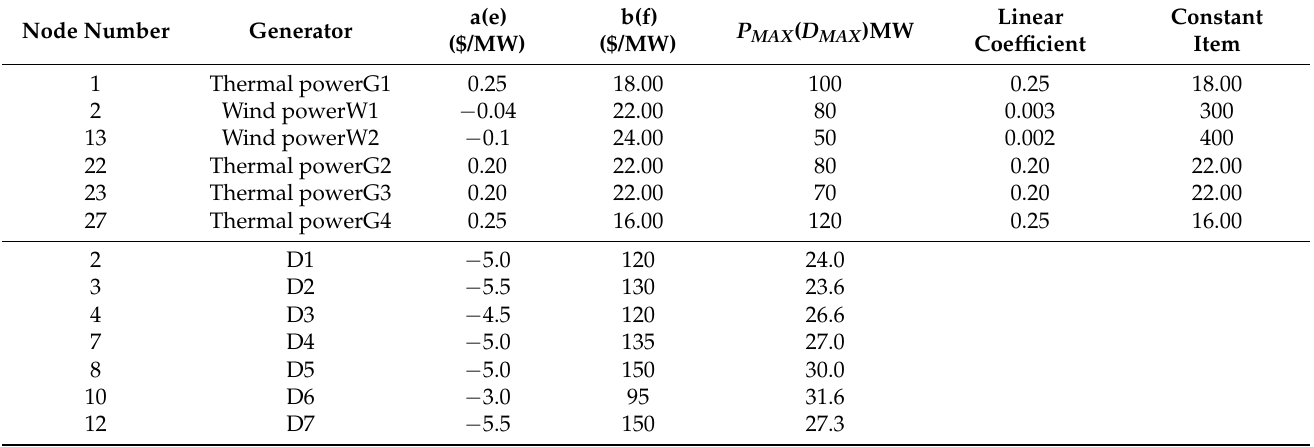
Table 4. Electricity generator and load